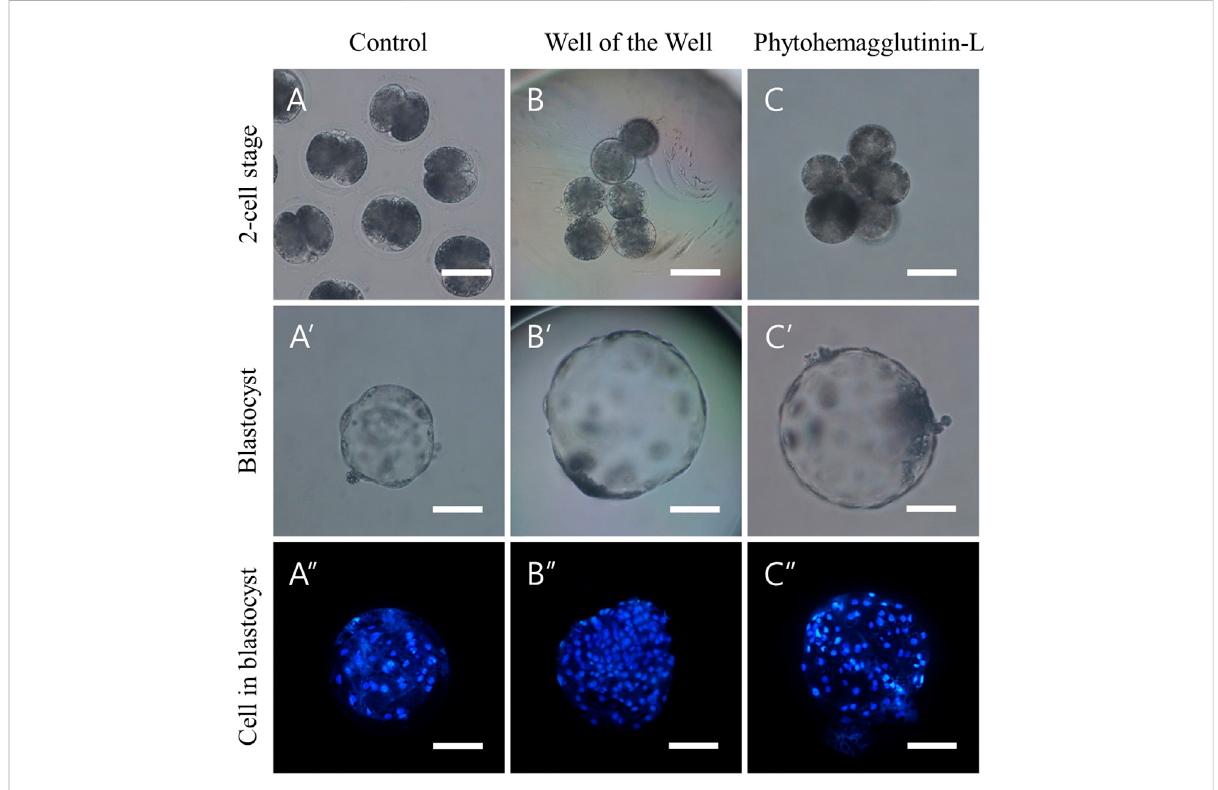
FIGURE 1 Aggregation of 2-cell stage blastomeres after parthenogenesis improves the quality of blastocysts. (A) Normal 2-cell embryos (B) 3x zona-free blastomeres aggregated by the well of the well (WOW), and (C) phytohemagglutinin-L (PHA-L) methods. Optical (A ′ – C ′ ) and fl uorescence (A ″ – C ″ ) microscope images of blastocysts derived from normal, WOW, and PHA-L methods. Scale bar = 100